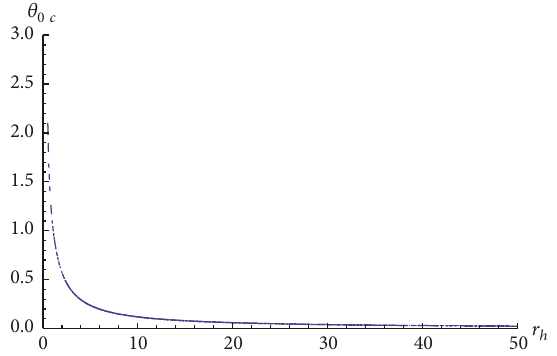
Figure 4: Relation between 𝜃 0𝑐 and 𝑟 ℎ for the case 𝑄 =0.5. 𝑟 ℎ . From Figure 4, we know that